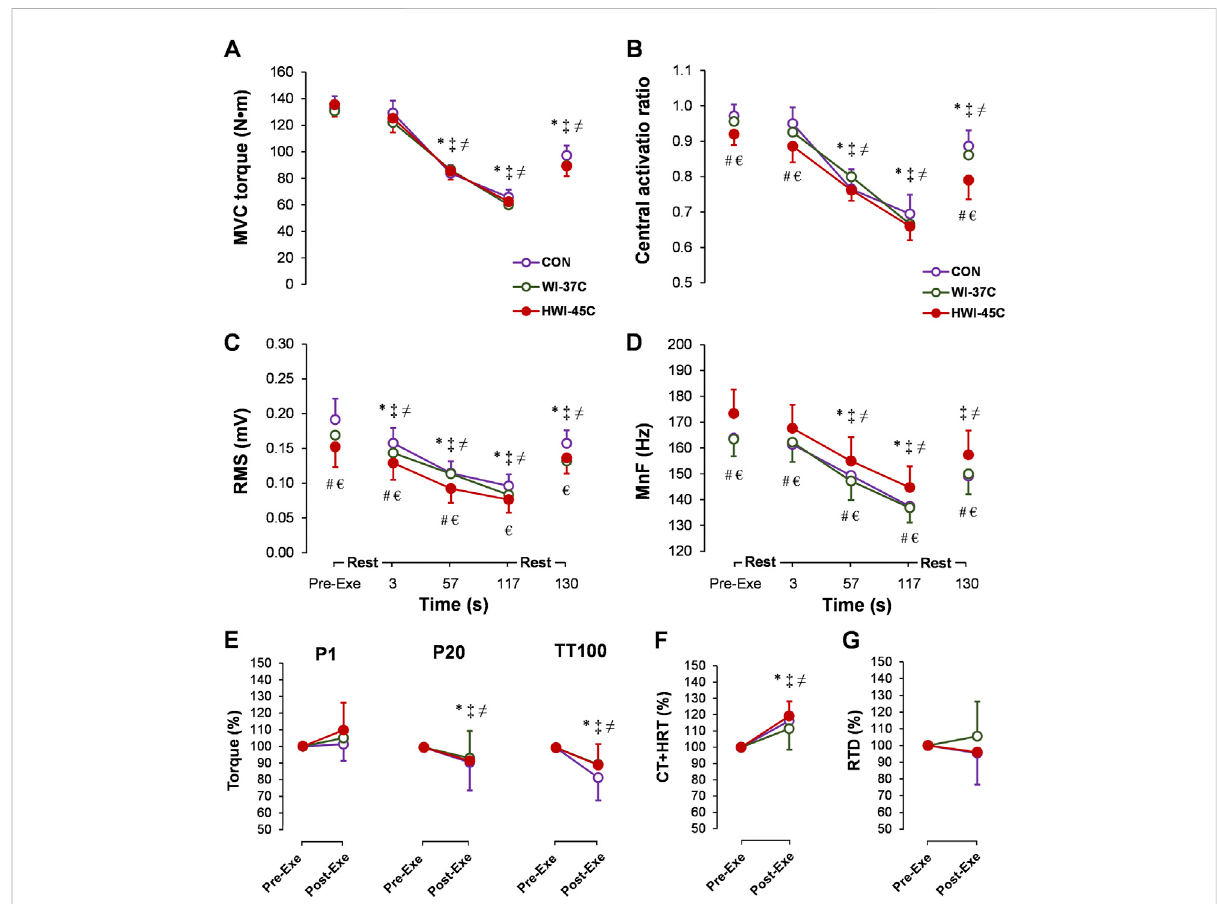
FIGURE 6 Time-dependentchangesinmaximalvoluntarycontractiontorque(MVC) (A) ,centralactivationratio (B) ,rootmeansquare(RMS) (C) ,andmean frequency (MnF) (D) of the sEMG signal of the soleus muscle during the 2-min MVC in the control (CON) trial and with whole-body immersions in water temperatures of 37 ° C (WI-37 ° C) and 45 ° C (HWI-45 ° C). Percentage changes from before to after the 2-min MVC in electrically induced torque (E) , TT100-induced muscle contraction plus half-relaxation time (CT + HRT) (F) , and peak rate of torque development (RTD) (G) in CON, WI- 37 ° C,andHWI-45 ° C.* p < 0.05,HWI-45 ° Ccomparedwithbefore; ‡ p < 0.05,WI-37 ° Ccomparedwithbefore; ≠ p < 0.05CON,comparedwithbefore; # p < 0.05, HWI-45 ° C, compared with WI-37 ° C; € p < 0.05, HWI-45 ° C compared with CON. Values are expressed as mean and